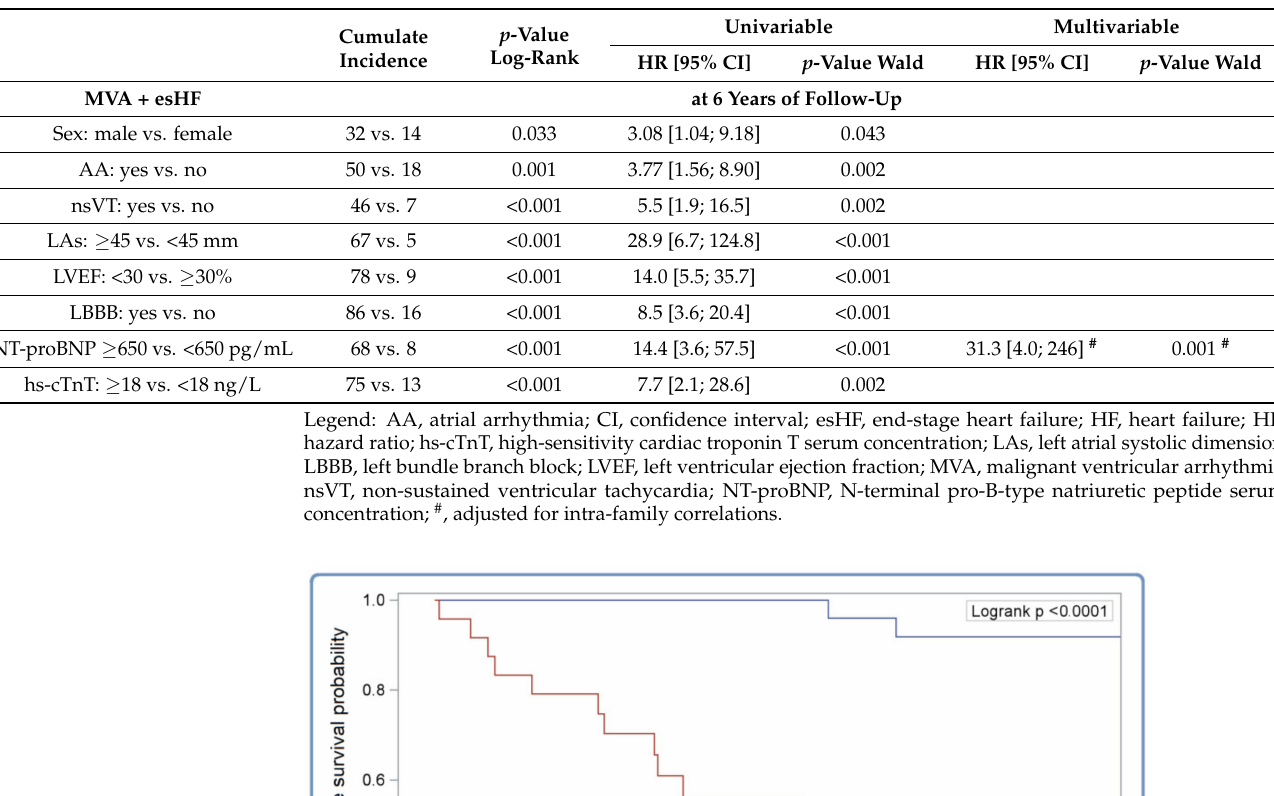
Table 3. Potential risk factors affecting occurrence of the composite endpoint of malignant ventricular arrhythmia and end-stage heart failure in cardiotitinopathy.